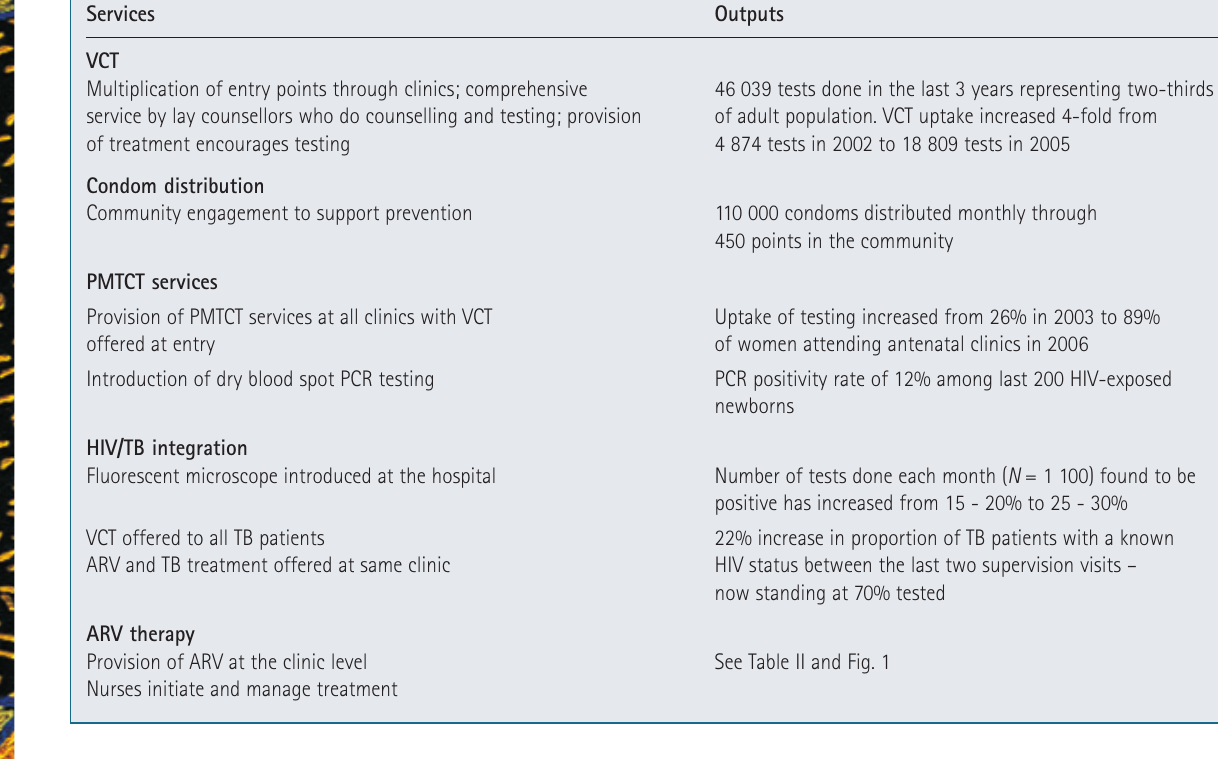
TABLE II. TWELVE-MONTH OUTCOMES AT CLINICS AND THE HOSPITAL, LUSIKISIKI